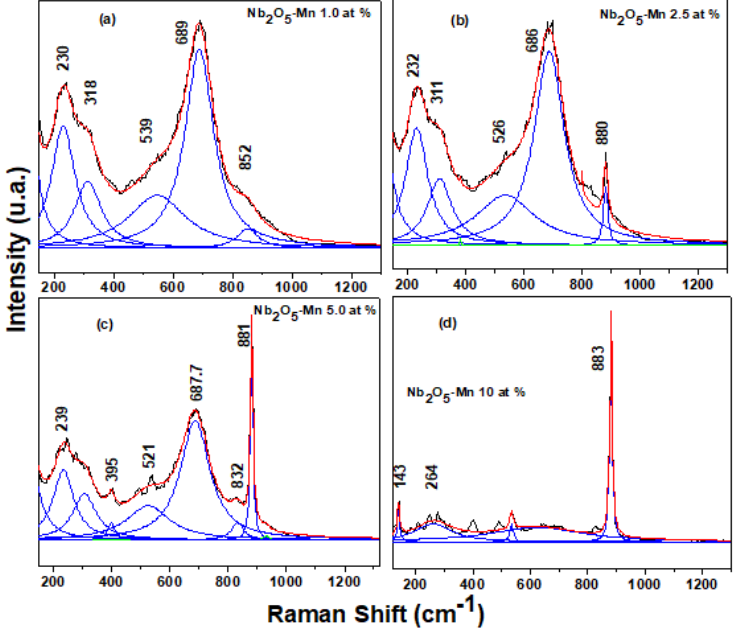
Figure 6. Raman spectra of Mn-doped Nb 2 O 5 samples obtained at 700 ◦